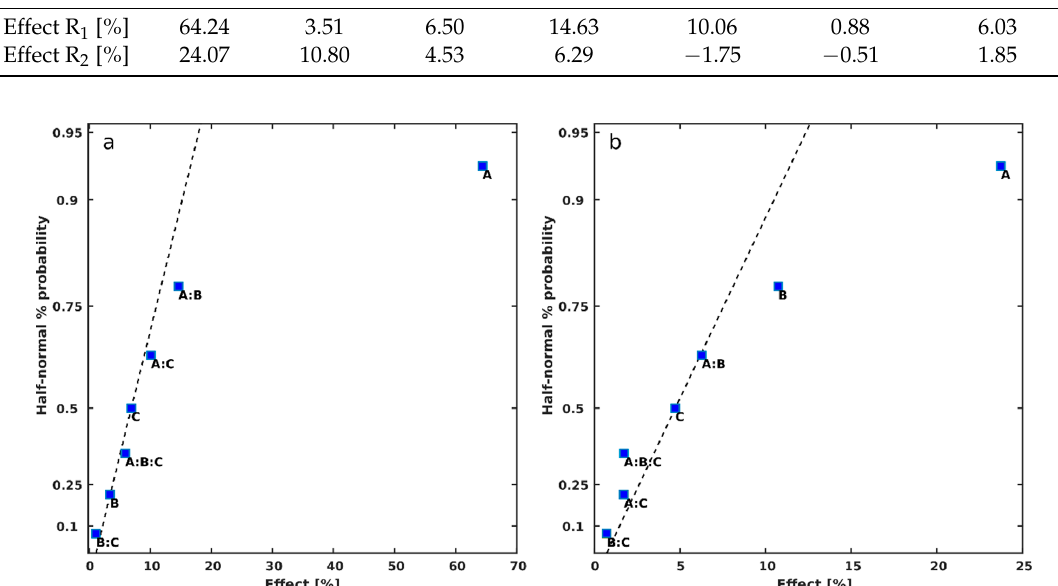
Table 5. Selected process parameters (factors) and their measured effects on de-O (R 1 ) and de-N (R 2 ) from experiments 1–8.